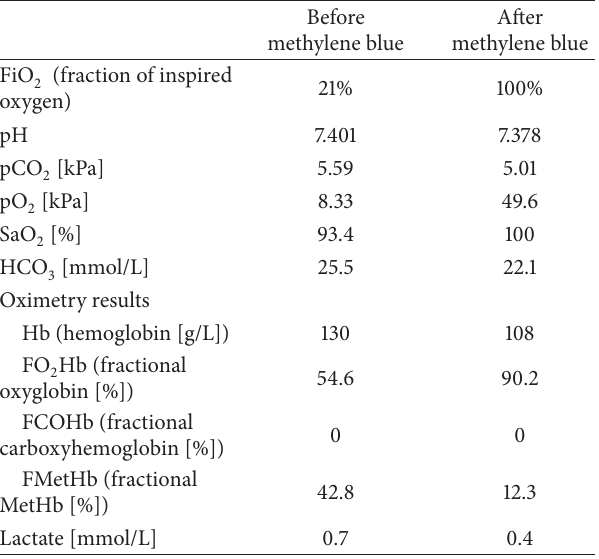
Table 2: Arterial blood gas before and after administration of first dose of methylene blue